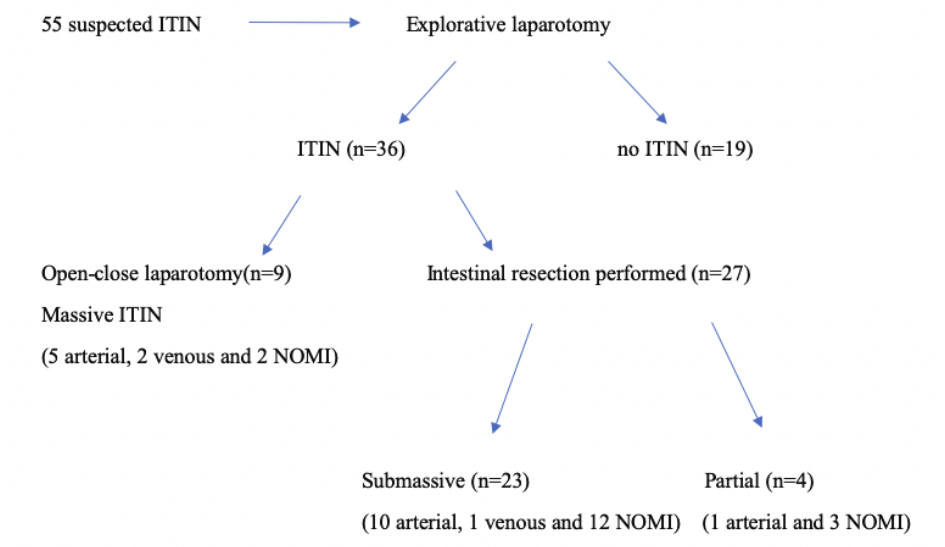
Figure 1: Flowchart of patients retrospectively analyzed Table 1: Overall demographics and clinical